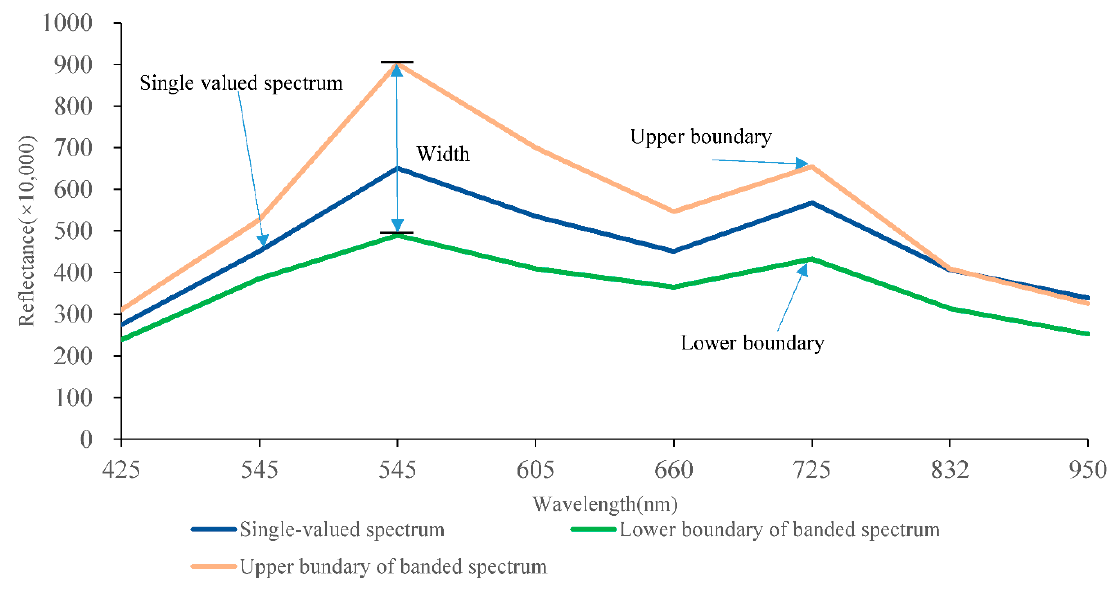
Figure 1. Single-valued and banded spectral curves.